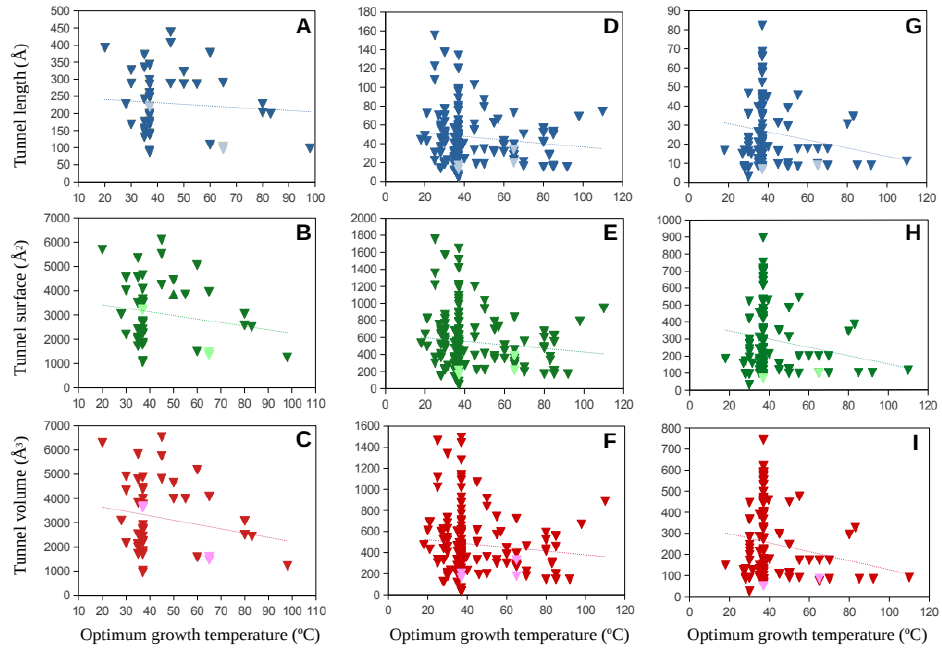
Figure 3. Molecular tunnel dimensions, length ( A , D , G ), surface ( B , E , H ), and volume ( C , F , I ) (in Å), predicted for the heterodisulfide reductase (Hdr) subunit genes, A ( A , B , C ), B ( D , E , F ), and C ( G , H , I ), from numerous methanogenic Archaea as a function of their optimum growth rates. Dark color-filled symbols correspond to predicted protein structures. Light color-filled symbols correspond to resolved model structures from the Protein Data Bank. Trend lines are presented as dotted